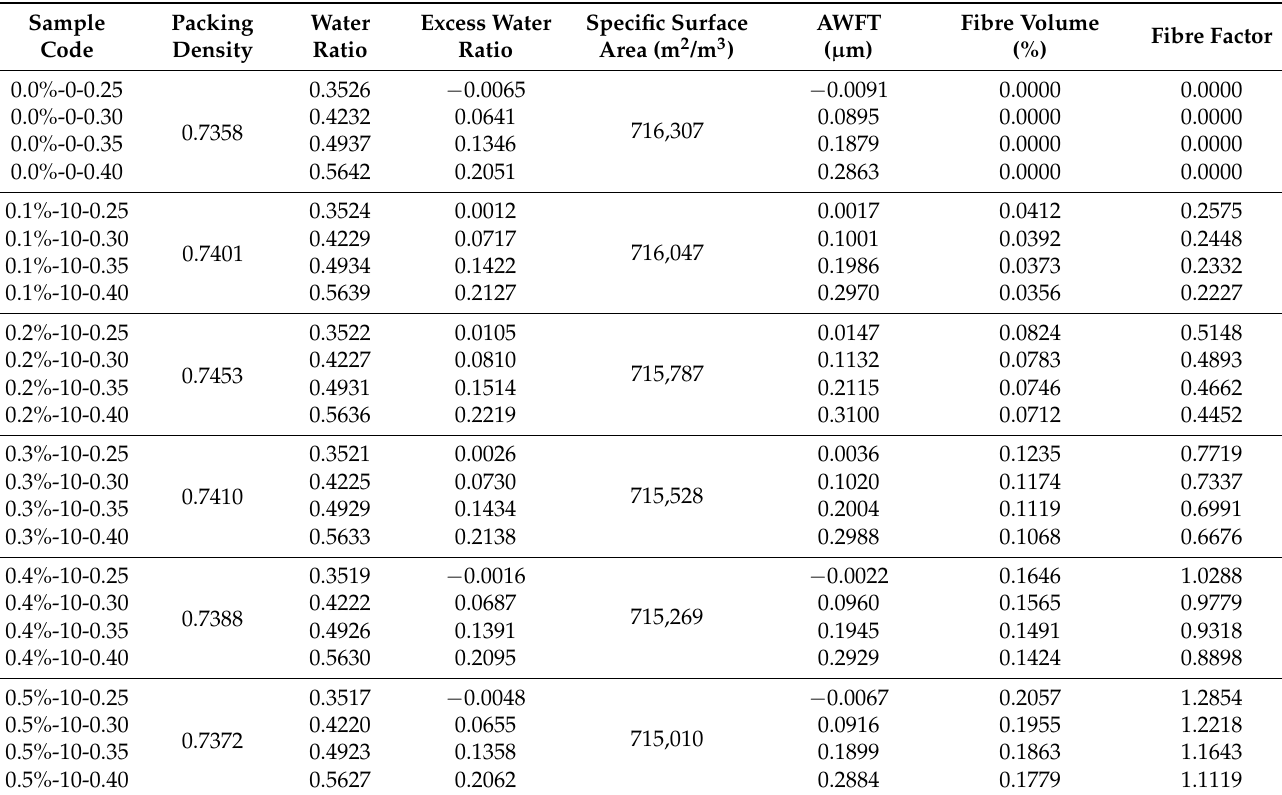
Table 6. Packing density and AWFT of mortar samples with varying fibre dosage and length = 10 mm.